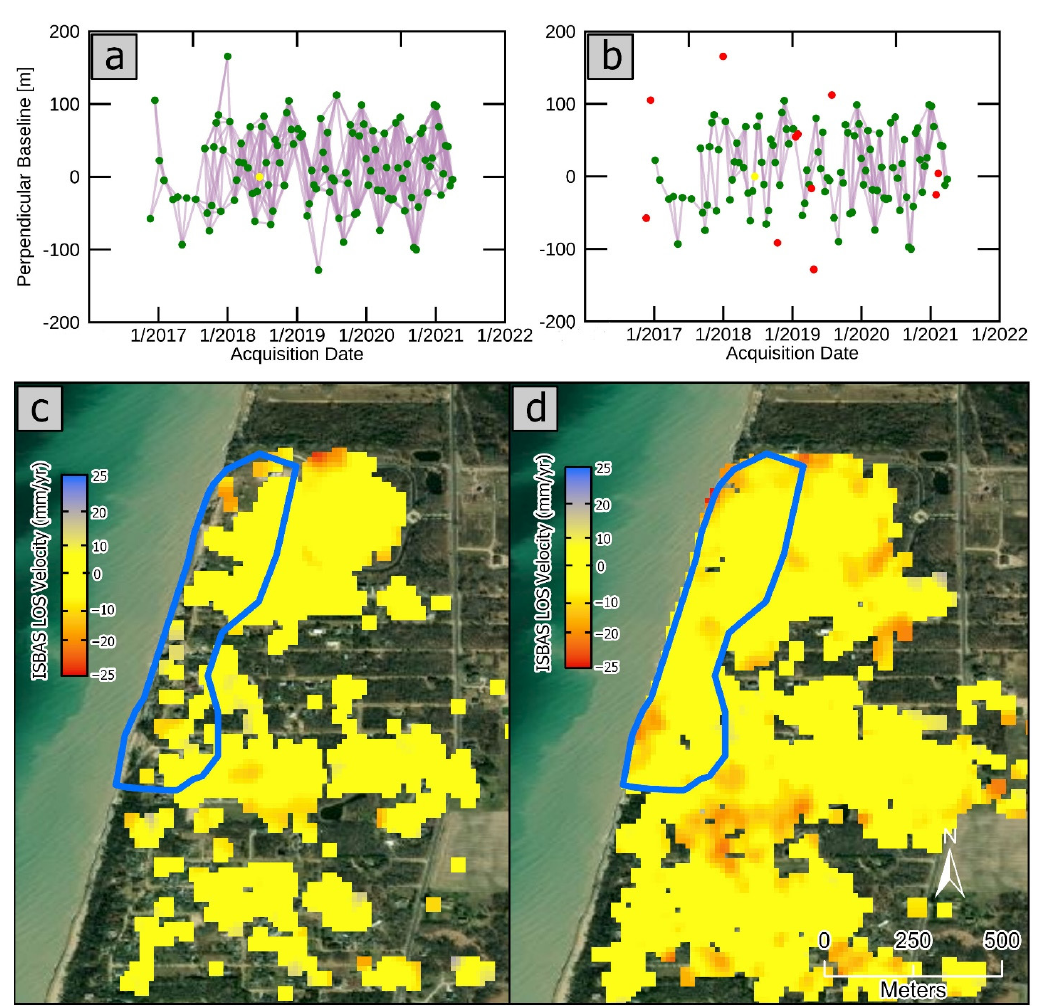
Figure 4. SBAS connection graphs (initial and refined) displaying the Sentinel-1 images (green dots), interferograms (lines connecting green dots), the reference image (yellow dot), and omitted images (red dots). ( a ) Initial SBAS connection network (Track 121) for all acquisitions (102 photos; 409 interferograms). ( b ) Refined connection graph after the exclusion of interferograms with low mean coherence (<0.3) (91 images; 229 interferograms). ( c ) Extracted deformation rate map over the study area (blue polygon) and surroundings based on the initial connection graph ( d ) Extracted deformation velocity map over the study area (blue polygon) and surroundings based on the refined connection graph. The average temporal coherence over the study area is 0.58 in Figure 4c and 0.8 in Figure 4d. Source of ArcGIS pro base maps in Figure 4c,d: Esri, DigitalGlobe, GeoEye, i-cubed, USDA FSA, USGS, AEX, Getmapping, Aerogrid, IGN, IGP, swisstopo, and the GIS User